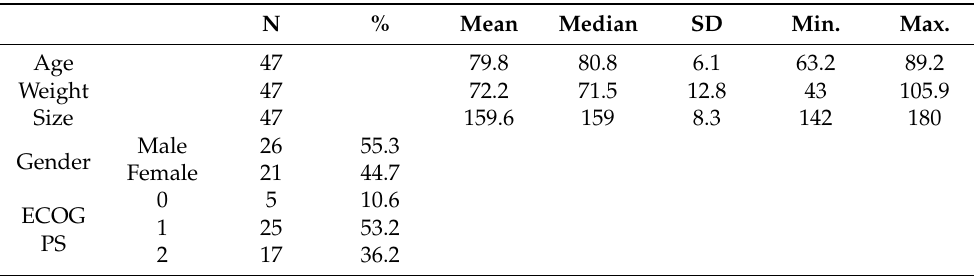
Table 1. Clinical characteristics of patients in the study. Epidemiologic characteristics (age, weight, size, gender, and ECOG performance status) are shown.